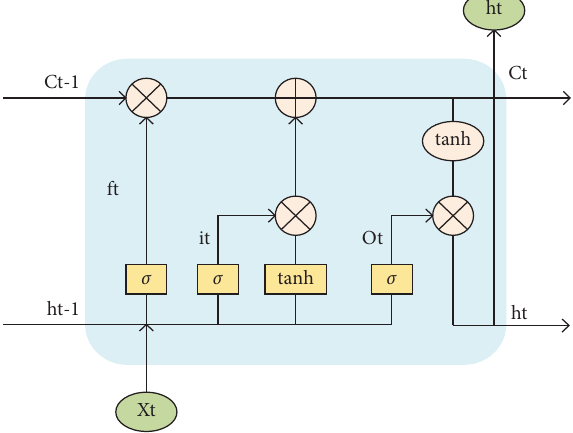
Figure 4: Schematic diagram of the LSTM